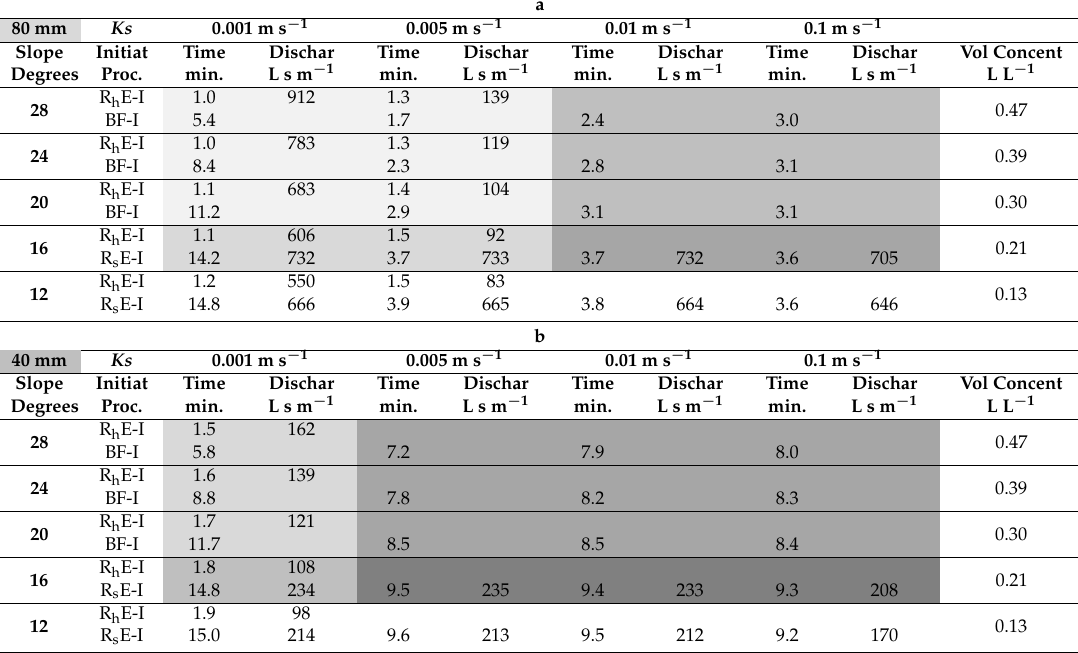
Table 4. Time sequence of different initiation processes R h E-I and R s E-I, (erosion by Hortonian and saturation overland flow respectively) and BF-I (bed failure) in relation with hydraulic conductivity ( Ks ) and slope angle of bed material. Further are given the discharge (discharg) and solid concentration (concent) during R h E-I and R s E-I. Tables 4a and 4b: simulated rain intensities of 80 mm and 40 mm, respectively. a 80 mm Ks 0.001 m s − 1 0.005 m s − 1 0.01 m s − 1 0.1 m s − 1 Slope Initiat Time Dischar Degrees Proc. min. L s m − 1